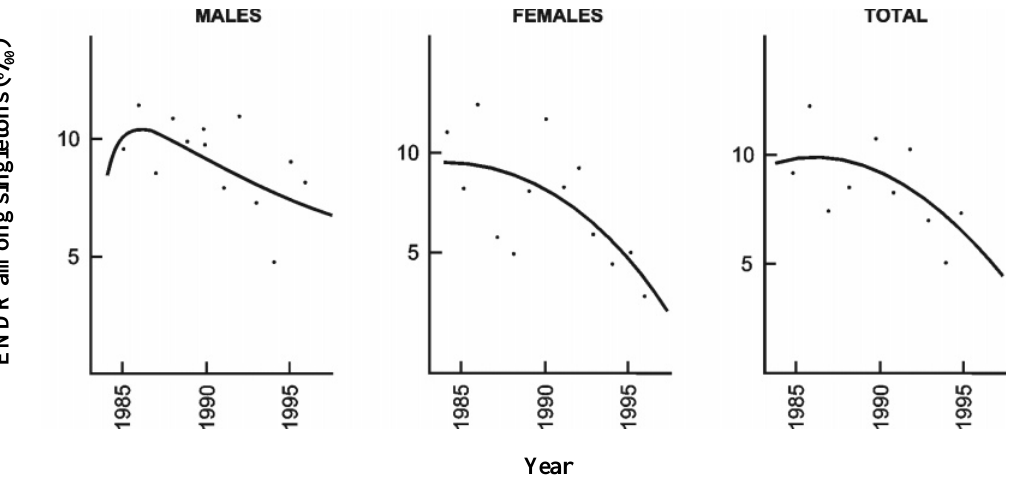
Figure 2 - Best fit regression curves for the annual distribution of the early neonatal death rate (ENDR) among singletons born from 1984 to 1996. Males: y = 10.383 e ( ln year - 1.129) 2 ; females: y = 9.483 + 0.147 year - 0.042 year 2 ; total sample: y = 9.288 + 0.253 year - 0.041 year 2 .